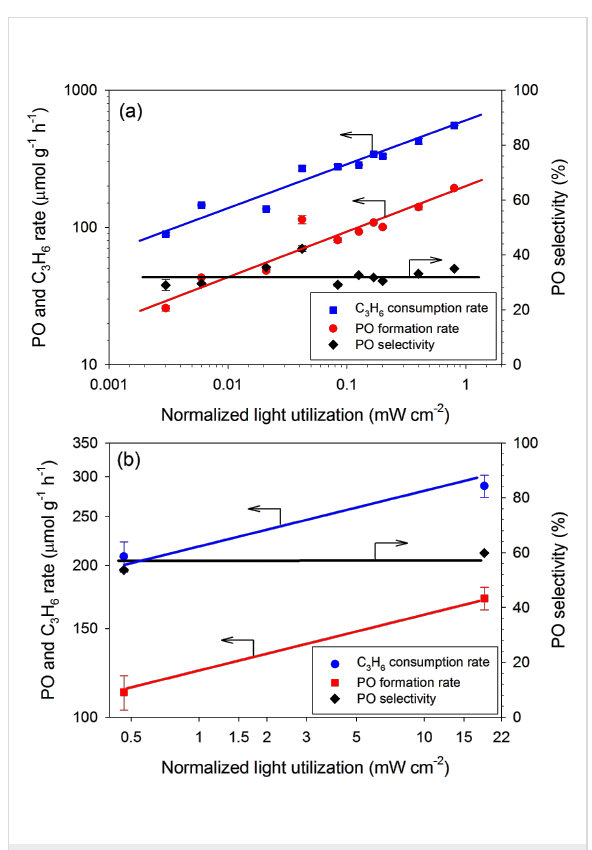
Figure 9: The PO formation rate, C 3 H 6 consumption rate and PO selectivity over V-Ti/MCM-41 versus the normalized light utilization by V-Ti/MCM-41 photocatalyst over (a) a mercury arc lamp and (b) a xenon lamp (see Table 2). Lines are presented for guiding and are not based on a kinetic